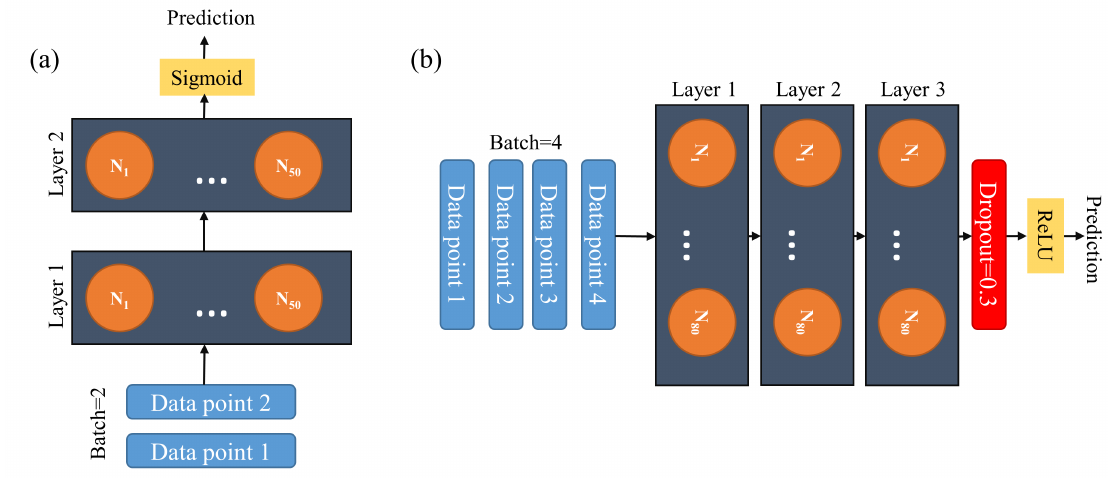
Figure 6. Examples of generated LSTMs. ( a ) LSTM with two hidden layers, 50 hidden units in each layer, batch size 2, and sigmoid activation function. ( b ) LSTM with three hidden layers, 80 hidden units in each layer, batch size 4, dropout 0.3, and ReLU activation function.